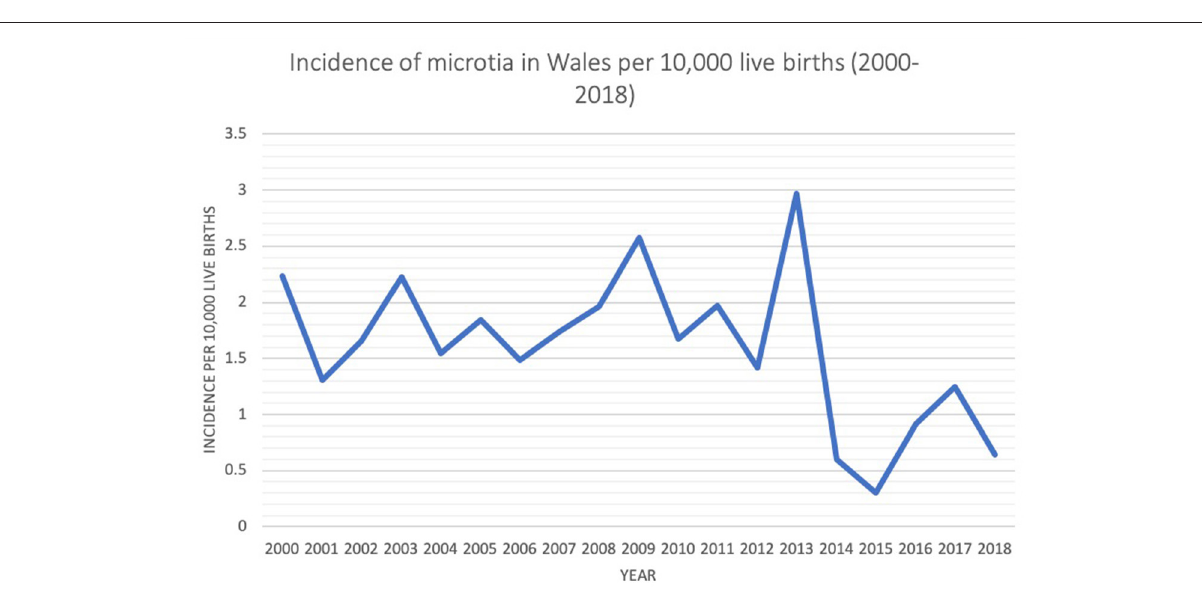
of age in the prosthetic cohort ( p = 0.02). WIMD score was higher (indicating less deprived) in the autologous cohort (3, IQR = 2–4) compared to the prosthetic group (more deprived; median WIMD score 2, IQR = 1–4) but this was not a statistically significant difference ( p =